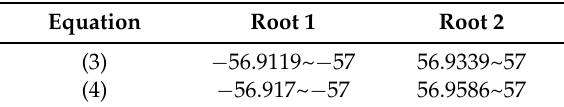
Table 2. Roots for the second degree equations (3) and